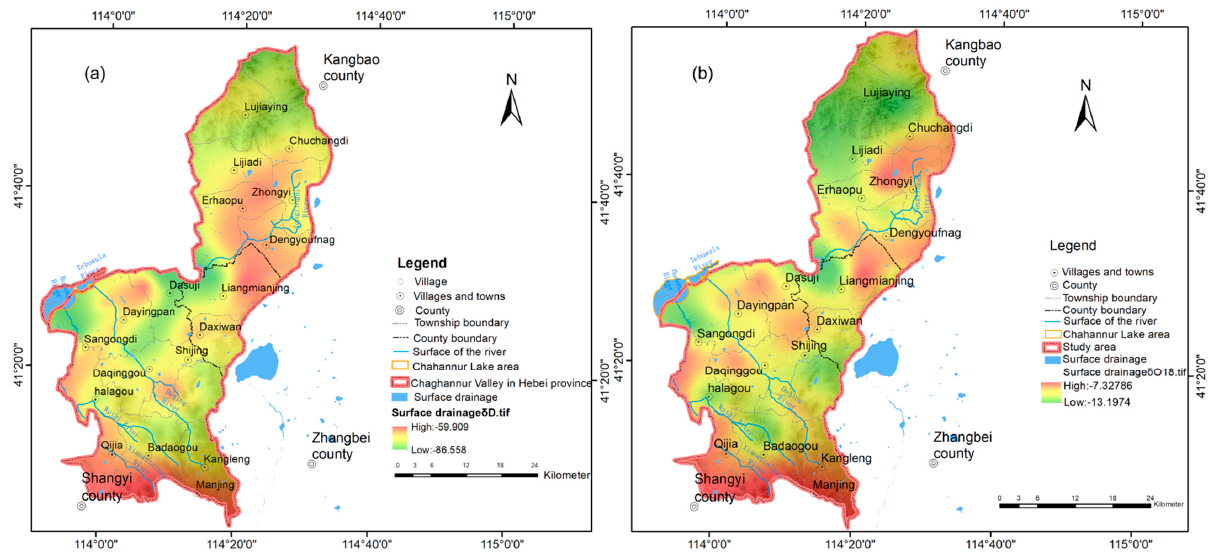
Figure 7. ( a ) Spatial distribution of δ 2 H isotope values and ( b ) spatial distribution of δ 18 O isotope